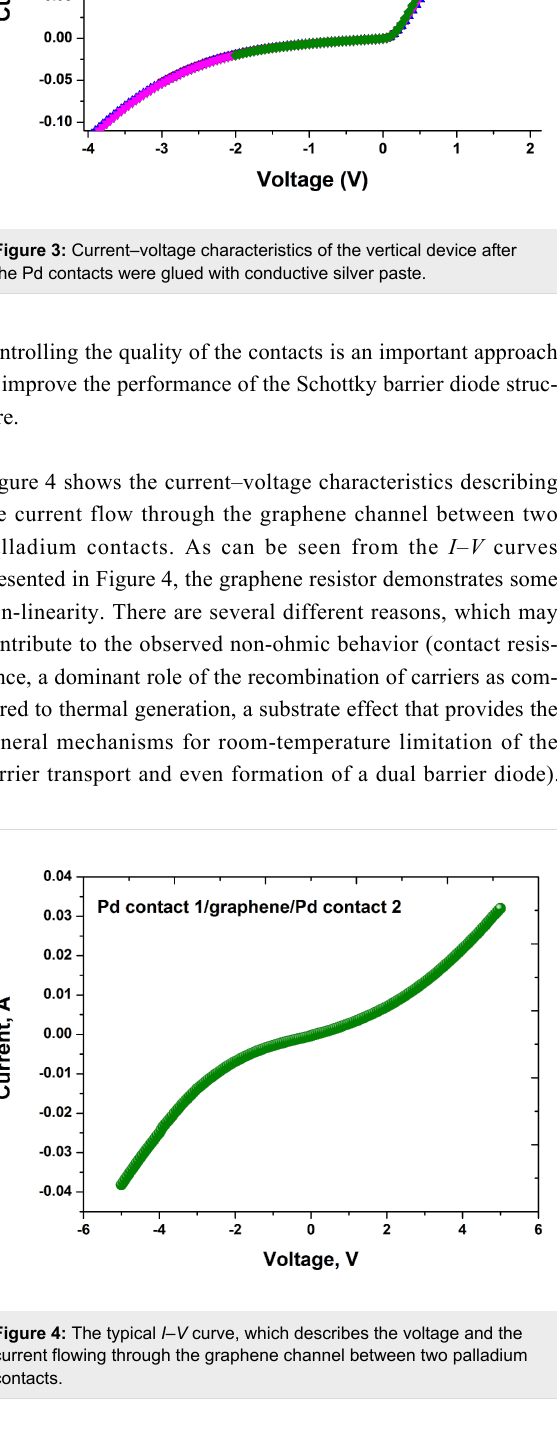
controlling the quality of the contacts is an important approach